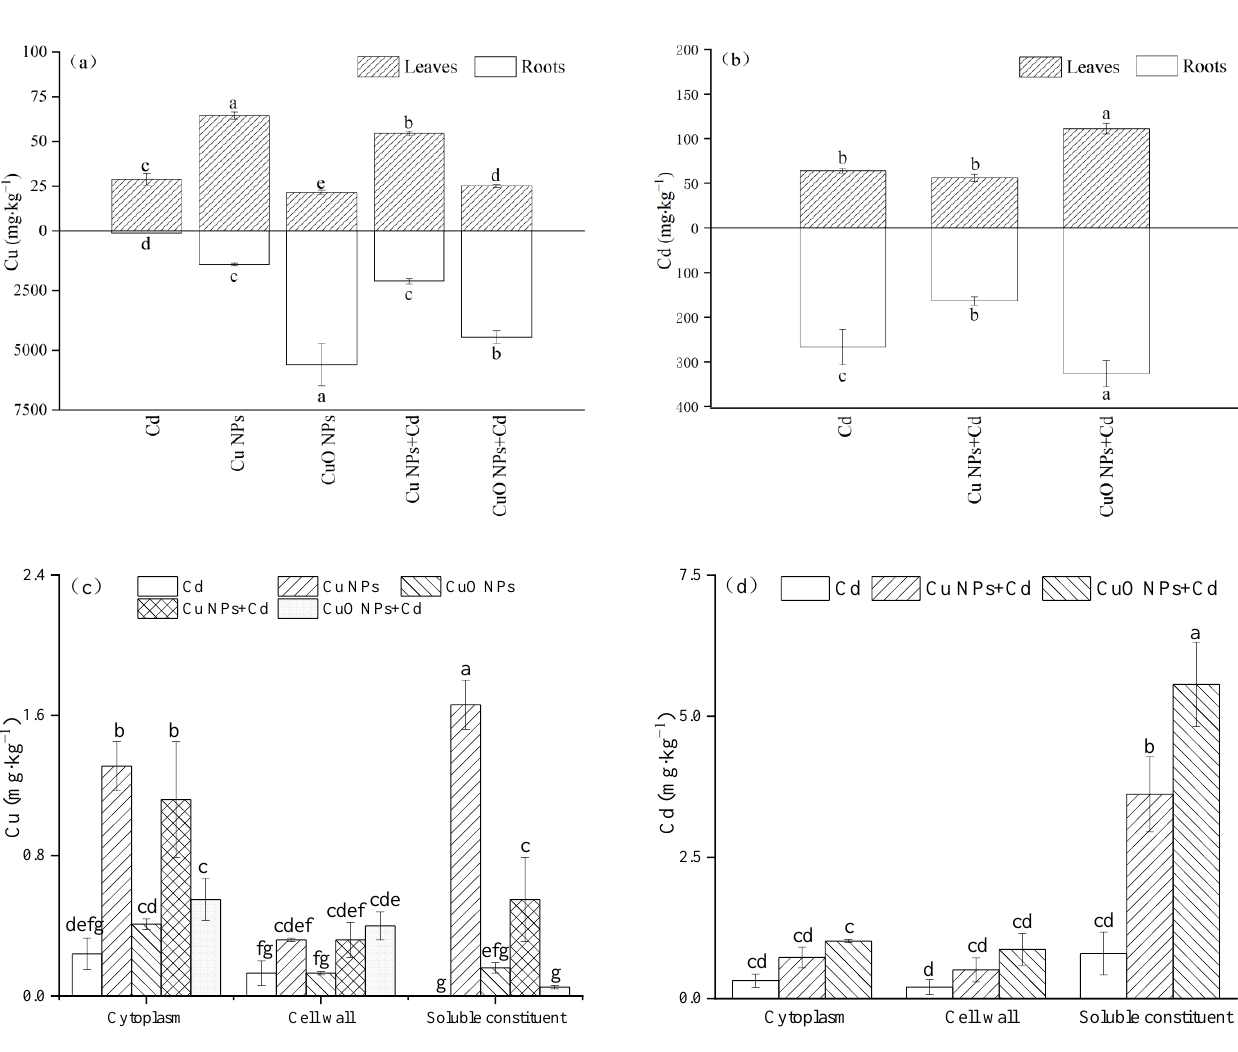
Figure 3. The effects of Cu NPs, CuO NPs and Cd on Cu ( a ), Cd ( b ), subcellular Cu ( c ) and subcellular Cd ( d ) content. The mean is the mean of three replicates and the error bars correspond to the standard deviation of the three values. Different letters above each column indicate significant differences among treatments in the same group ( p < 0.05).